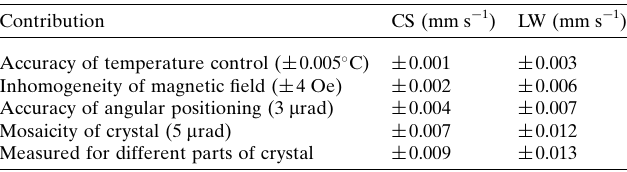
Table 1 Estimated variations of the central shift (CS) and effective linewidth (LW) of SMS radiation caused by various contributions, and as measured for different parts of the iron borate crystal.